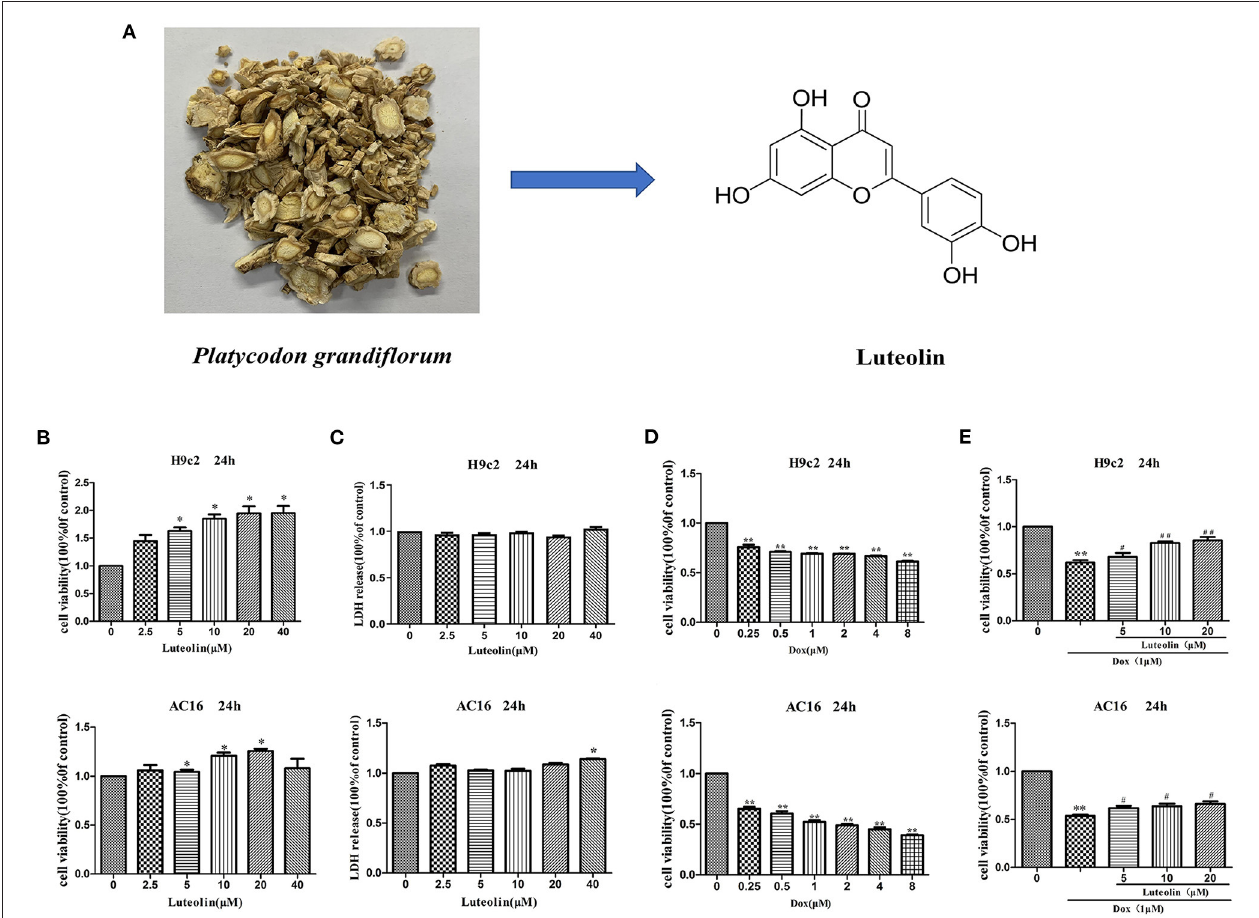
FIGURE 1 | Effect of Lut in attenuating Dox-induced cardiotoxicity in H9c2 and AC16 cells. (A) Chemical structure of Lut. (B,C) Effects of different concentrations of Lut on cell viability and toxicity in H9c2 and AC16 cells. (D) Effects of different concentrations of Dox on cell toxicity in H9c2 and AC16 cells. (E) Effects of Lut in attenuating Dox-induced cardiotoxicity in H9c2 and AC16 cells. Mean ± SD, n = 3 independent experiment. * P < 0.05; ** P < 0.01 compared with control group. # P < 0.05; ## P < 0.01 compared with Dox